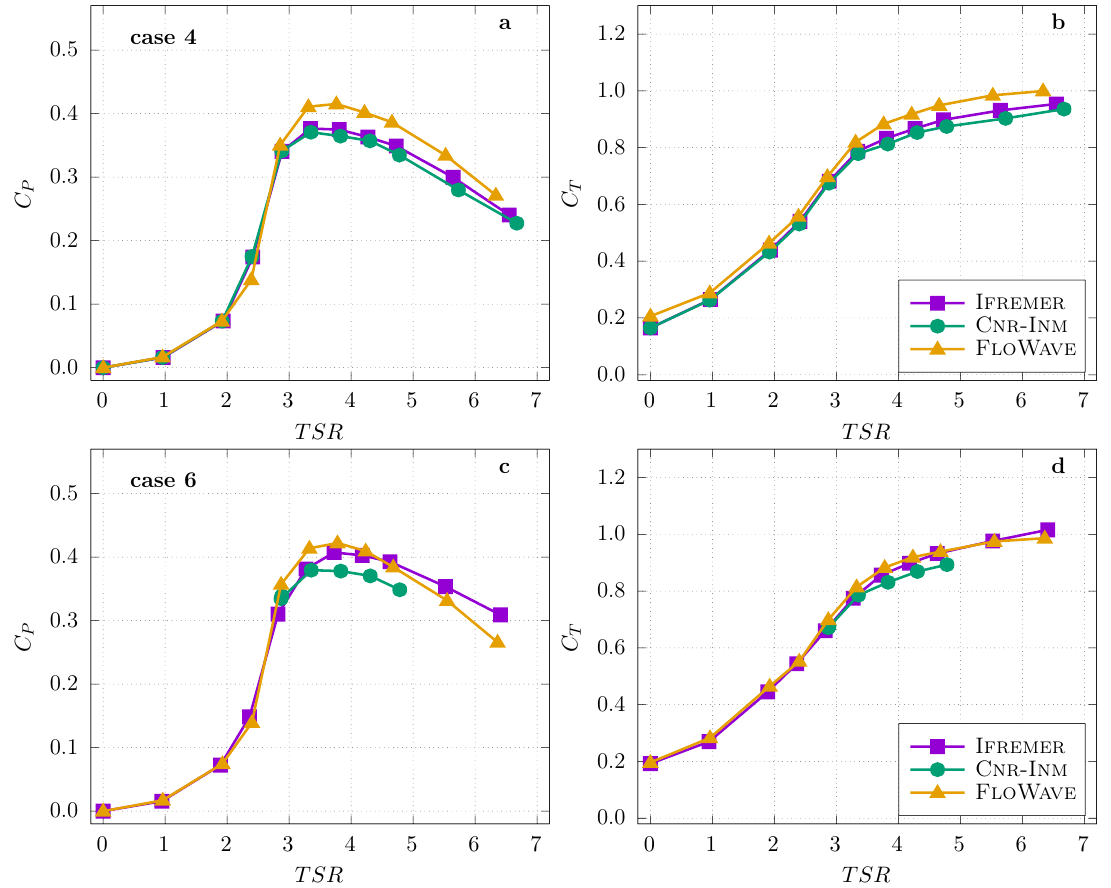
Figure 17. Power ( a , c ) and thrust ( b , d ) coefficients comparison accounting for blockage correction: Case 4 with current-only at 1.0 m/s ( a , b ), case 6 with regular wave and current of 1.0 m/s ( c , d ), versus TSR